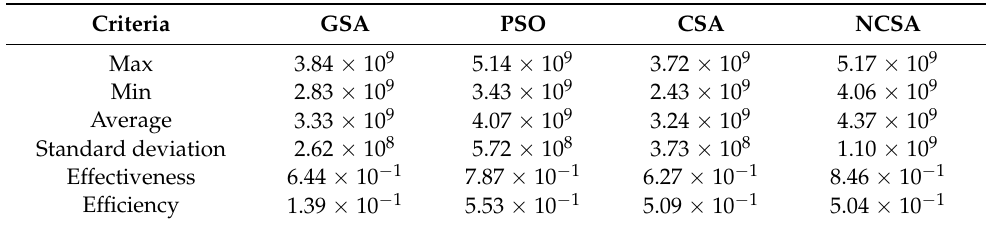
Table 6. Statistical data of applied metaheuristic algorithms on well placement optimization for case study 1.